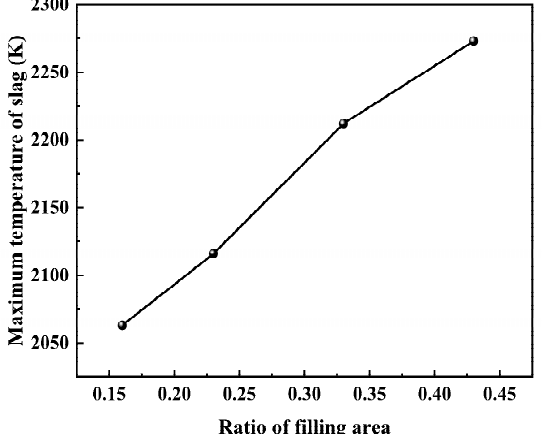
Figure 4. Effect of filling ratio on maximum slag temperature.